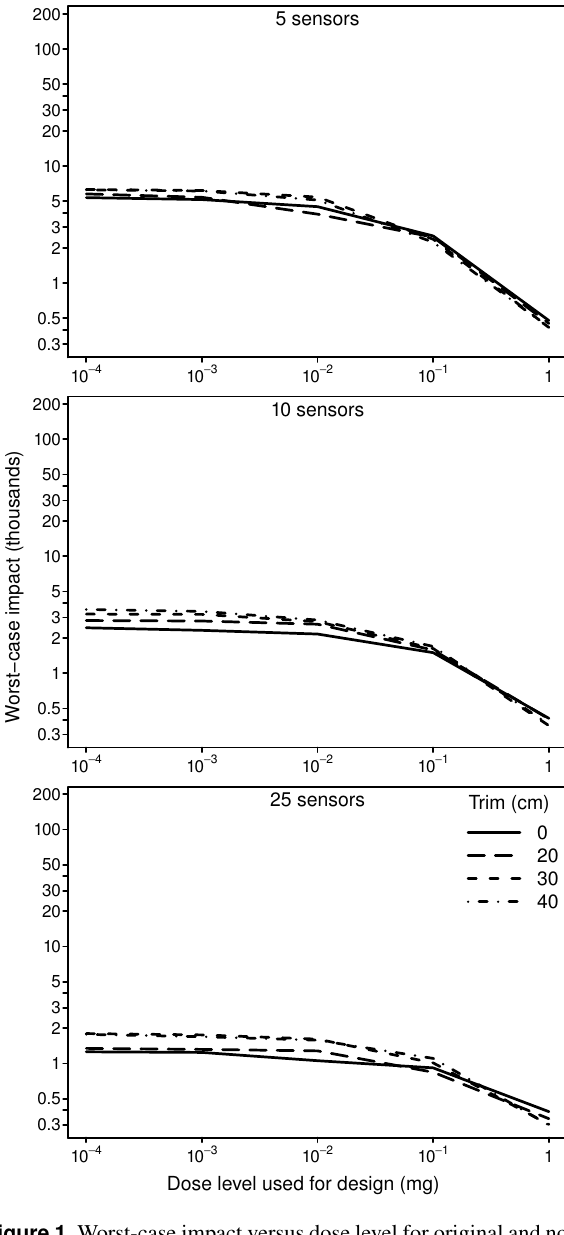
Figure 1. Worst-case impact versus dose level for original and non- transplanted, worst-case CWS designs for Network N1. Results are shown for the original model and three levels of network skele- tonization